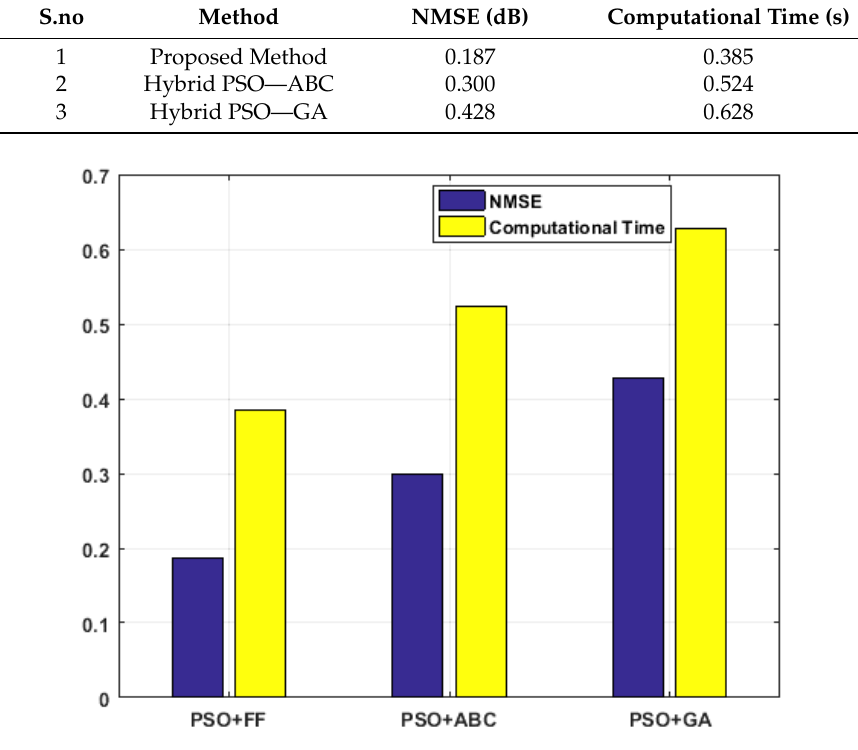
Figure 9. Performance evaluation of the proposed method.